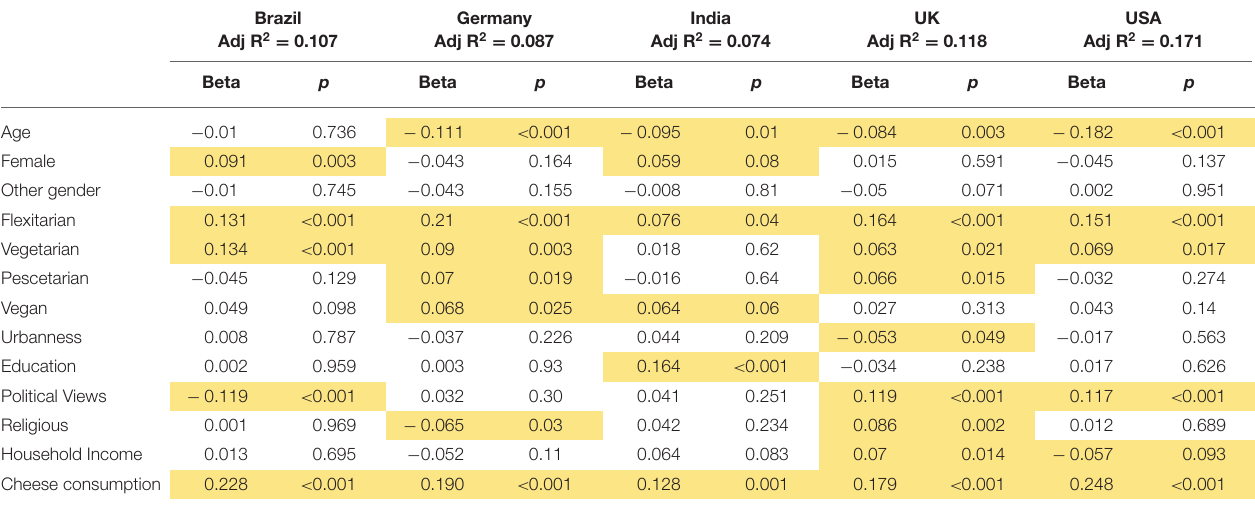
TABLE 2 | Regression models showing demographic and dietary predictors (standardised β ) of intention to purchase animal-free dairy cheese in Brazil, Germany, India, the UK and the